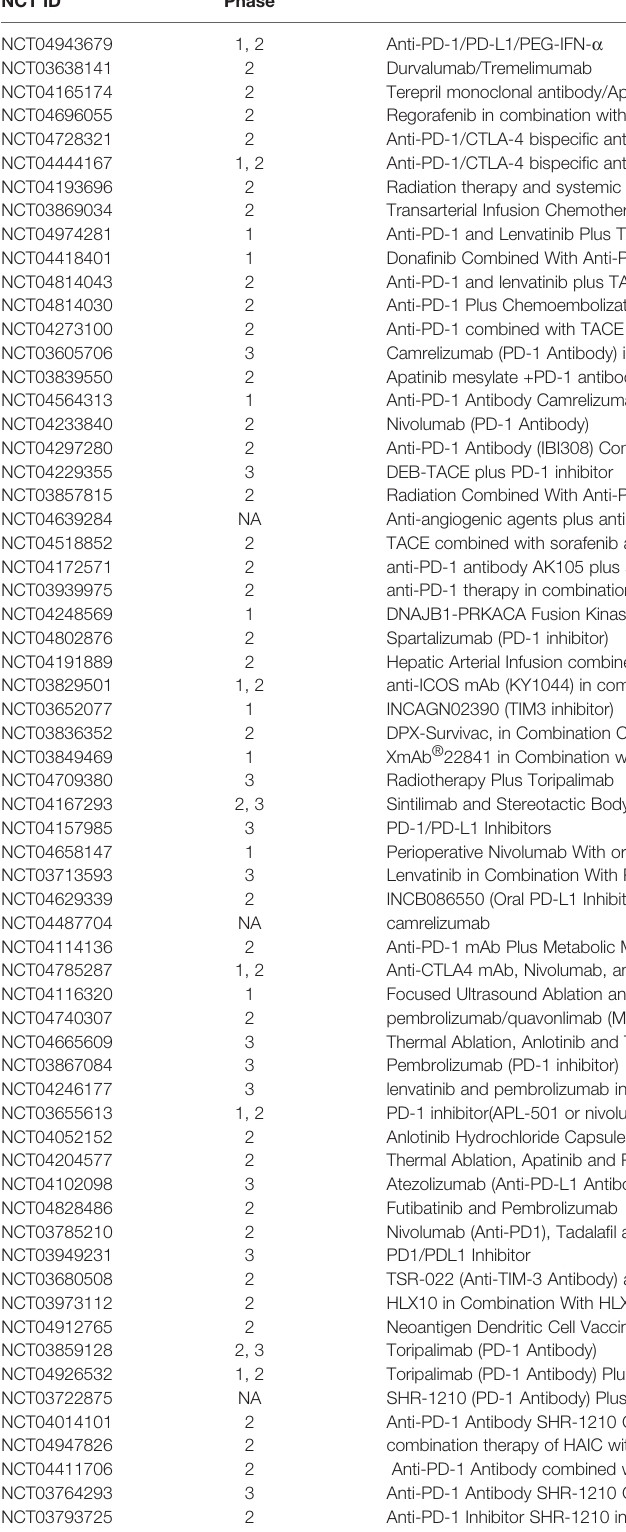
TABLE 1 | Clinical trials of ICIs therapy for HCC the last three years (www.clinicaltrails.com). NCT